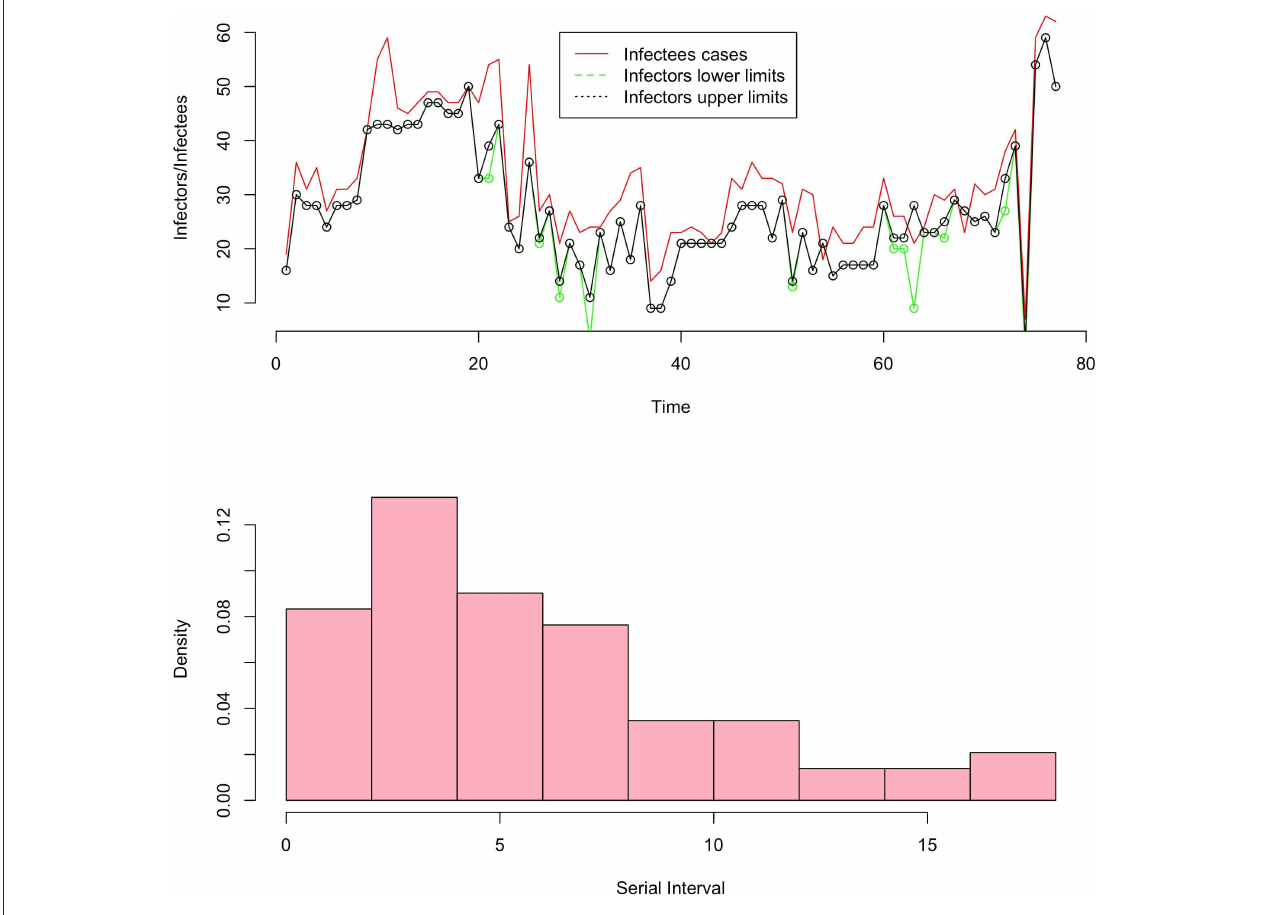
FIGURE 2 | Evolution of the infector and infectee pairs and histogram of the serial interval.